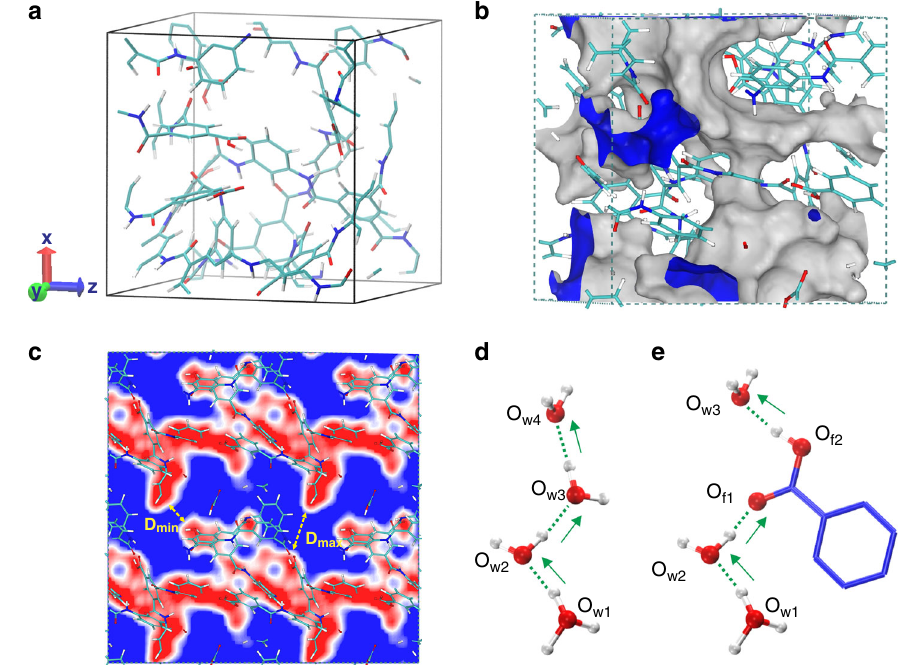
Fig. 3 Structure, channel and proton conduction of thin- fi lm composite membranes. a The optimized structure. b 3D channels (inner surface: blue). c 2D channel (accessible area: blue) as well as the framework (unaccessible area: red) parallel to y and z -axis. The red, blue, cyan and white represents O, N, C and H atom, respectively. d Transfer through water molecules. e Transfer through carboxyl groups as well as water molecules. Red, blue and white color represents O, C and H atom,